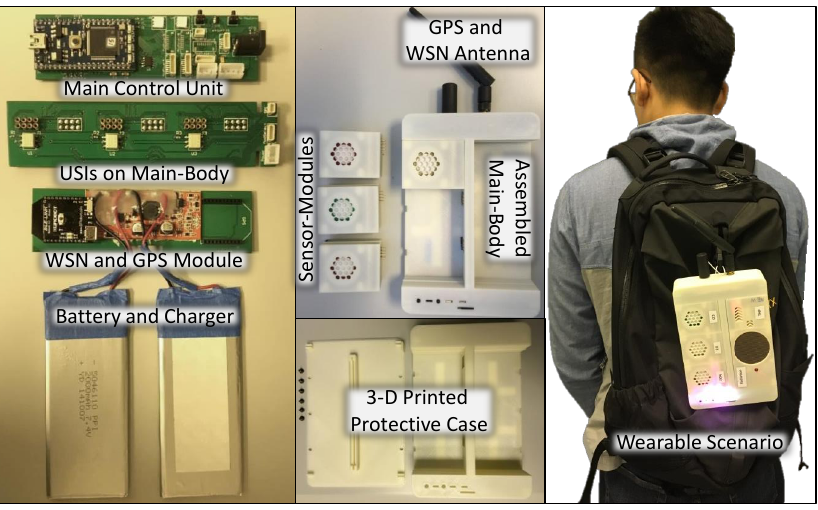
Figure 2. Main-Body subsystem and sensor nodes in wearable